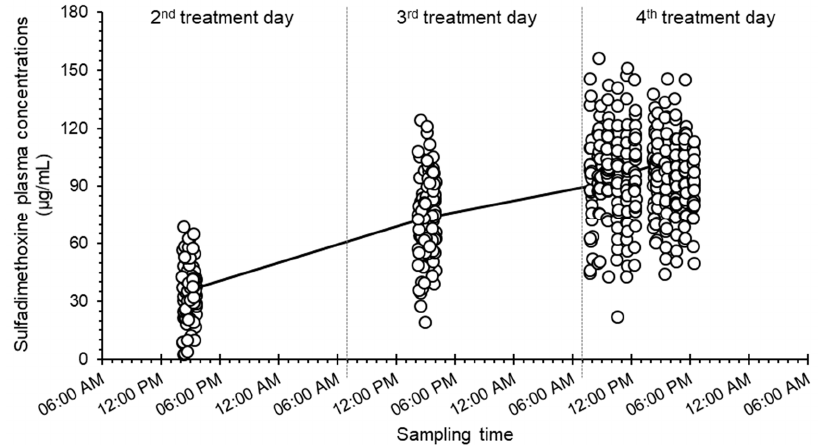
Figure 5. Individual SDM plasma concentrations for the 100 lambs in pen 2 that received an SDM-TMP combination (Trisulmix ® Liquid, 37.4 mg/kg/24 h SDM + 8.0 mg/kg/24 h TMP) for 4 days in the drinking water. The stock solution in the metering pump was renewed every morning around 07:00 am. Each circle corresponds to the plasma concentration for one lamb. The solid line links the average plasma concentrations.